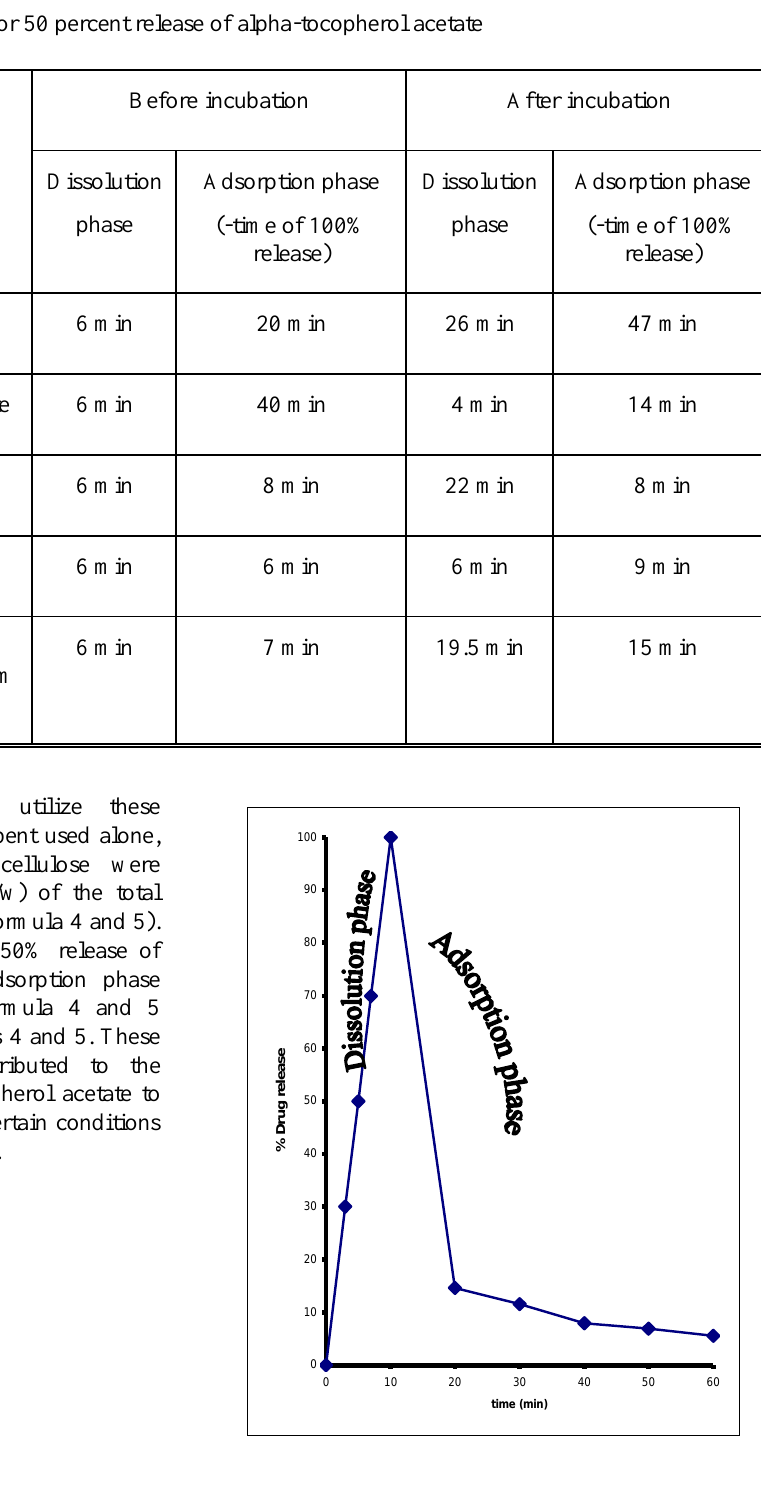
Figure 4: The percent of alpha-tocopherol acetate released from adsorbent mixture of kaolin and magnesium carbonate at pH 1.2 before incubation